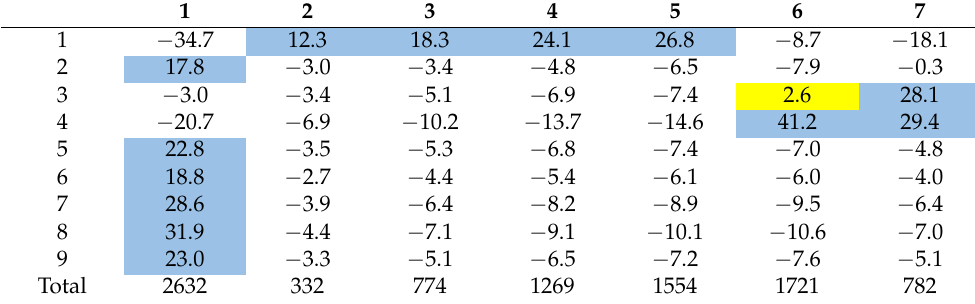
Table A13. Theoretical frequencies DRF 2006 (C1/Class_1122).